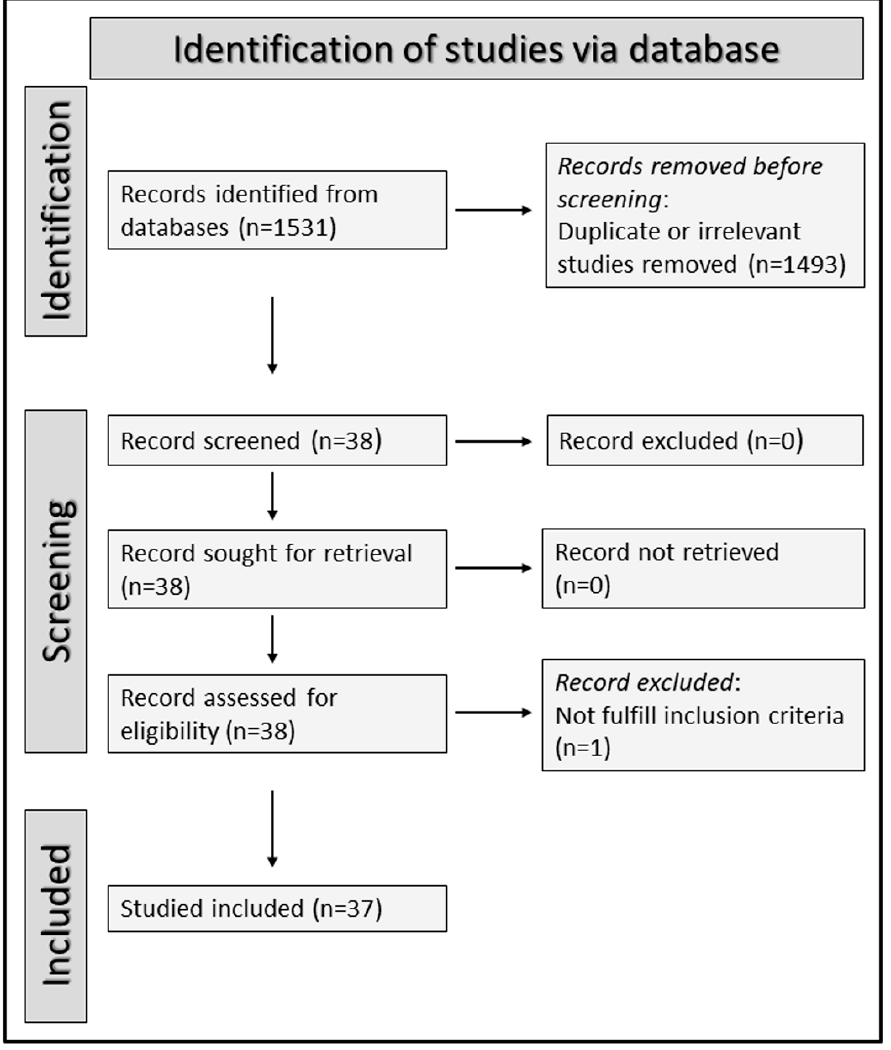
Figure 1. PRISMA 2020 flow diagram.